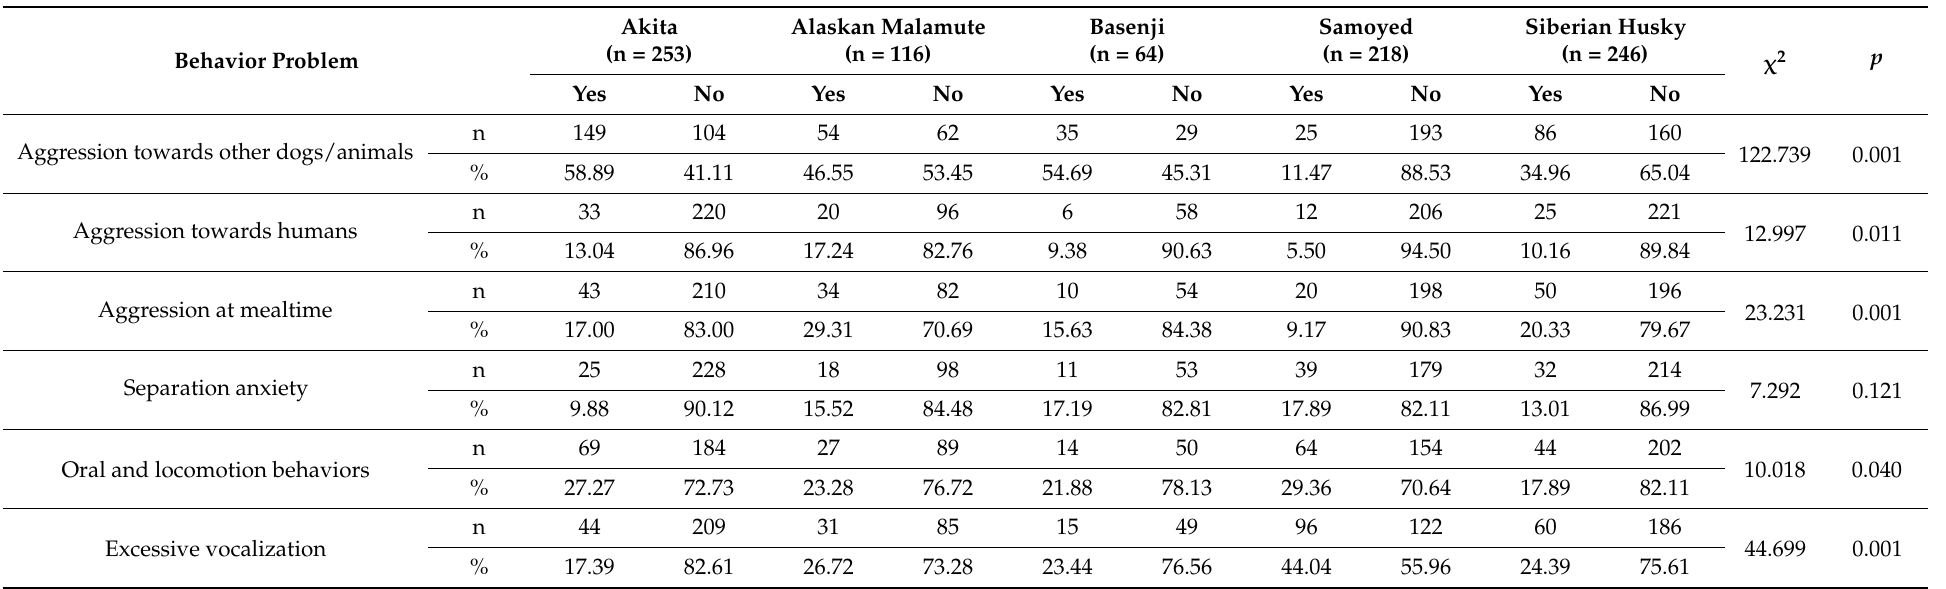
Table 2. The influence of breed on the incidence of undesirable behaviors in ancient dog